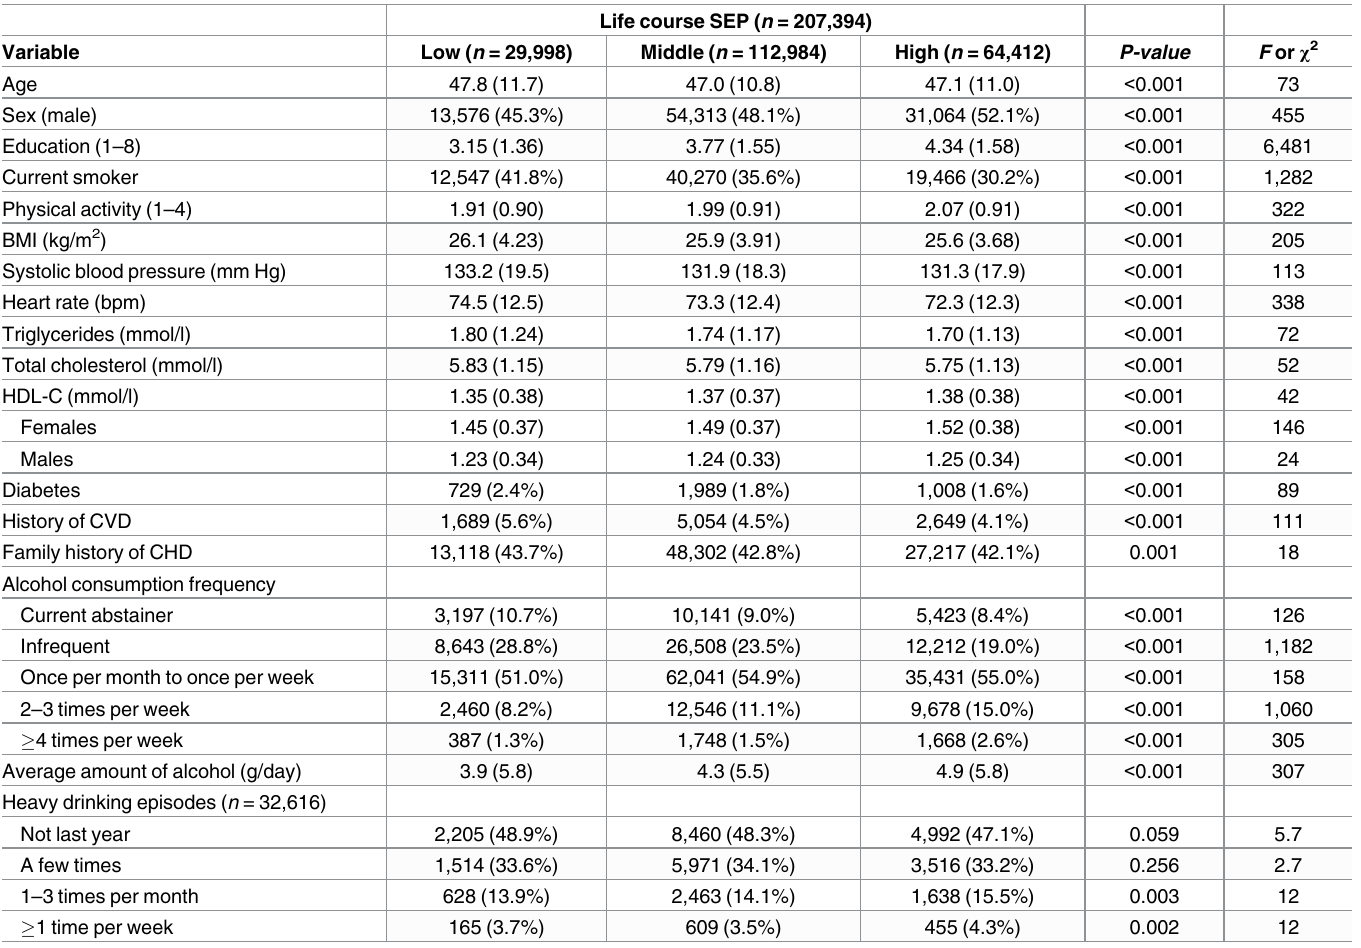
Table 1. Descriptivecharacteristics of the study population at baseline according to categories of life course